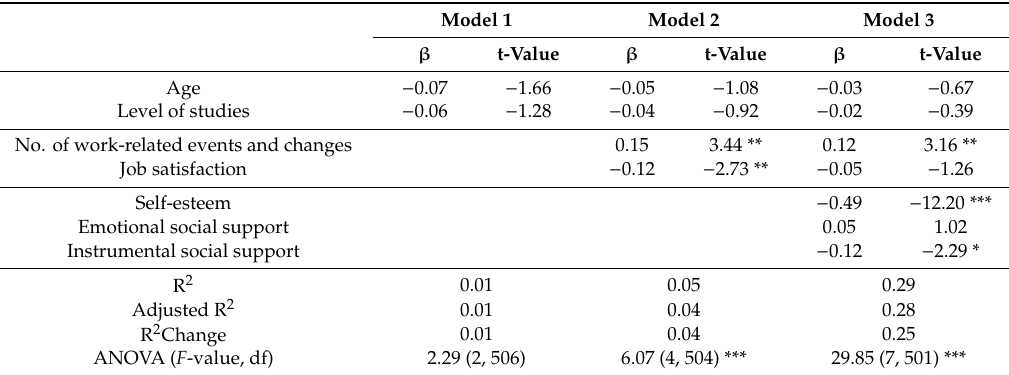
Table 2. Summary of the hierarchical multiple regression analysis with psychological distress as a dependent variable for the male sample.